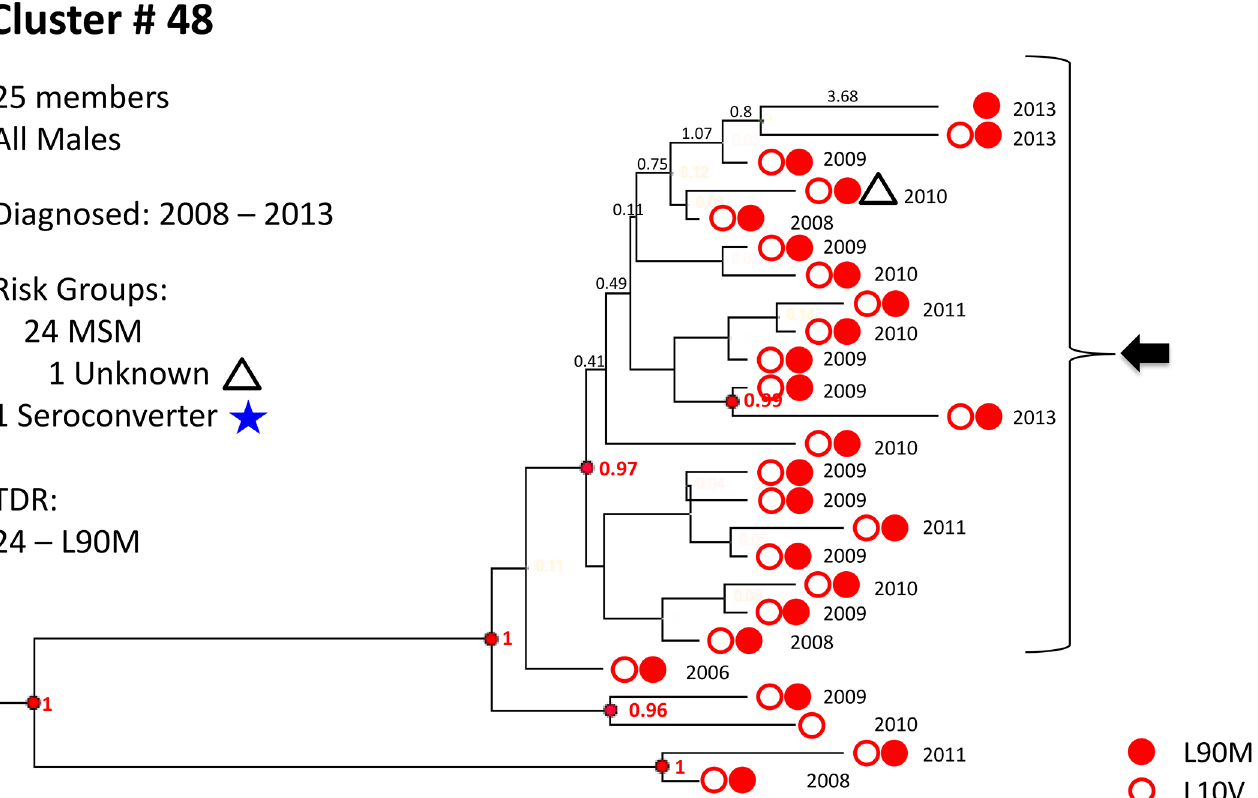
Fig 5. Cluster # 48. The first of three examples of large subtype-B clusters embedded in Fig 4. Cluster 48 is composed of 25 males, 24 of them MSM, diagnosed and genotyped between 2008 and 2013. All but one harbored the protease mutations L90M and L10V; the remaining one had only L10V. The group contains one seroconverter who was diagnosed in 2008. 20 members had a posterior probability of recent common ancestor > 0.99 and had short branches. Year of genotyping is indicated as well as branch lengths in years and selected resistance related mutations. Posterior probabilities (cid:1) 0.99 are indicated in red. Blue asterisk – seroconverters; green triangles – heterosexual males; green circles – heterosexual females; white triangles – male, risk group unknown; yellow triangles – IVDU males; yellow circles – IVDU females; FSU, Former Soviet Union; Hetero, heterosexuals; IVDU, intravenous drug users; MSM, men who have sex with